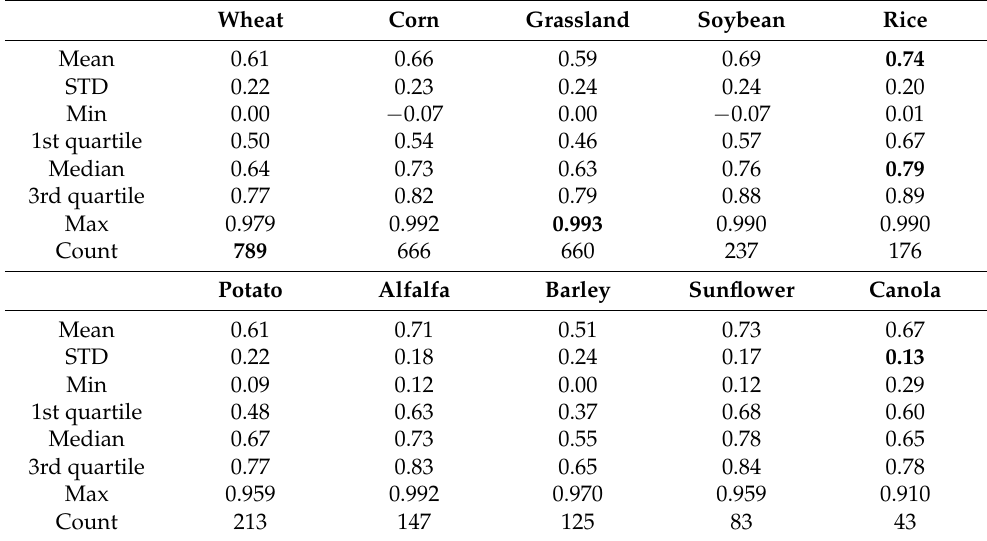
(Figure 17b), most non-parametric methods yielded lower accuracy variances as a collective of research results. A comparison between non-parametric and parametric models showed that the median of non-parametric algorithms is higher than parametric regression models. Table 4. Statistical analysis of R 2 in various crops.